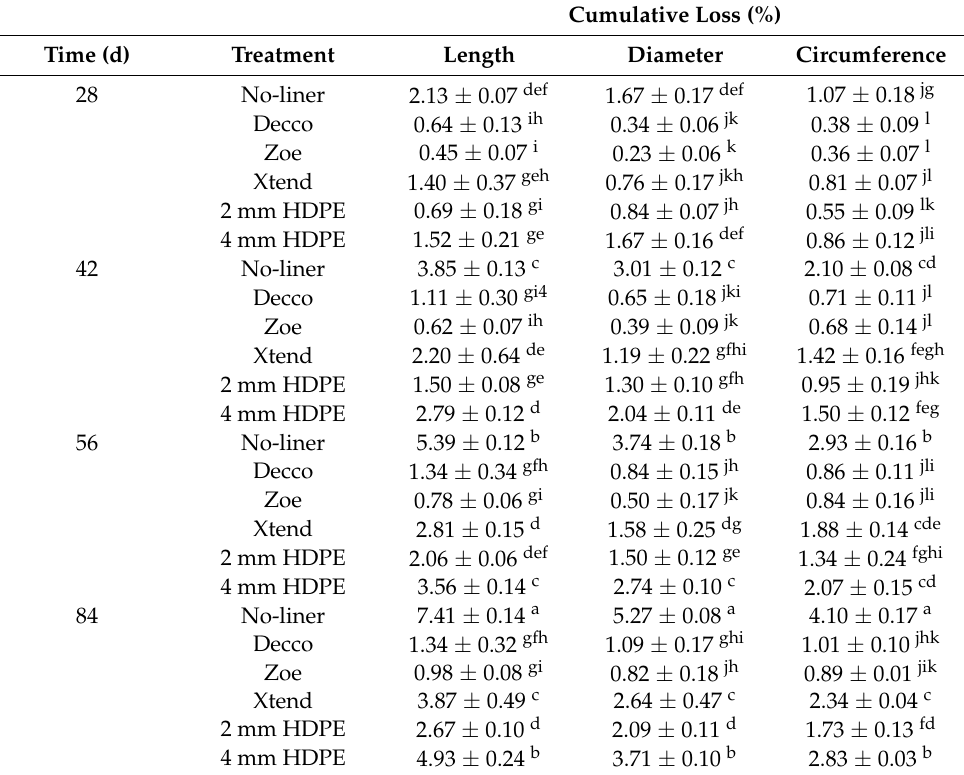
Table 3. Effect of plastic liner treatment on cumulative loss in fruit length, diameter, and circumfer- ence of pomegranate (cv. Wonderful) fruit stored at 5 ◦ C and 90% relative humidity